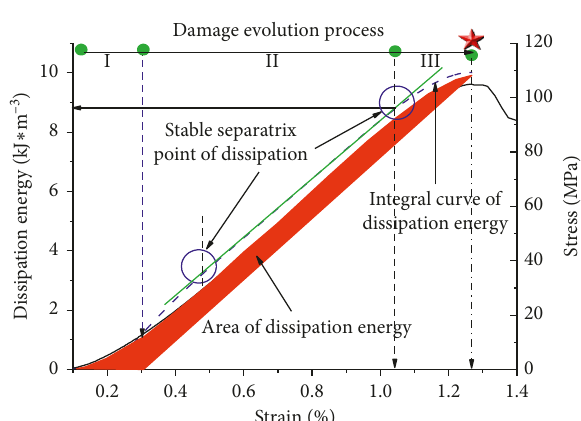
Figure 7: Relationship curves between strain stress and dissipative energy damage evolution process by sz-20.